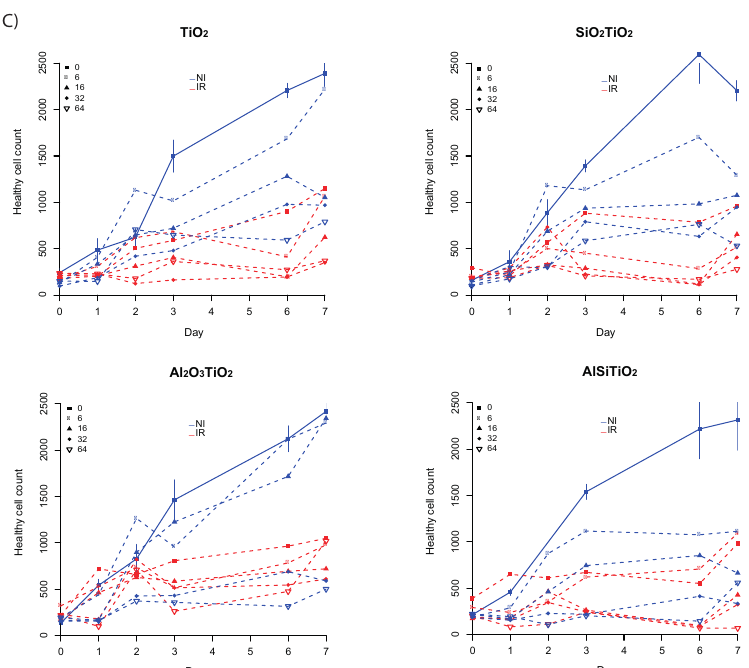
Figure 3. Cell growth after treatment by TiO 2 NMs followed by microscopy. 16HBE14o- cells are platted in six wells plates at 2.5 × 10 4 and treated 24 h after with no NMs, 6, 16, 32 or 64 µ g / cm 2 , combined or not with 4 Gy irradiation. Microscopy pictures are taken immediately (10 × magnification) ( A ) at day 0 until ( B ) day 7 after treatment on fixed cells, stained with Hoechst 33342. ( C ) The average of the cell number is obtained for each type of TiO 2 until day 7 (the standard deviation is only shown for the non-irradiated control group for figure readability).